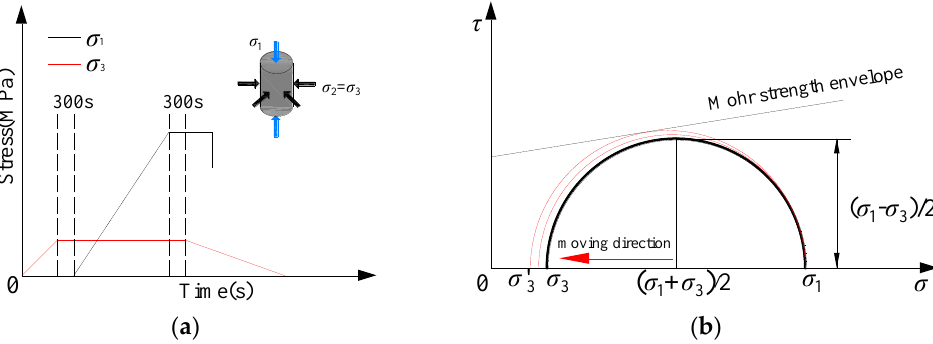
Figure 3. Experimental process and principle. ( a ) Stress process of rock specimen; ( b ) Experimental principle.